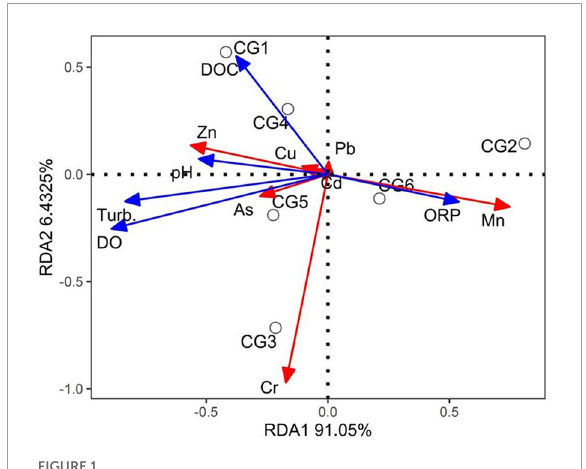
FIGURE1 RDA analysis of influencing factors of metals during the ice-covered period.